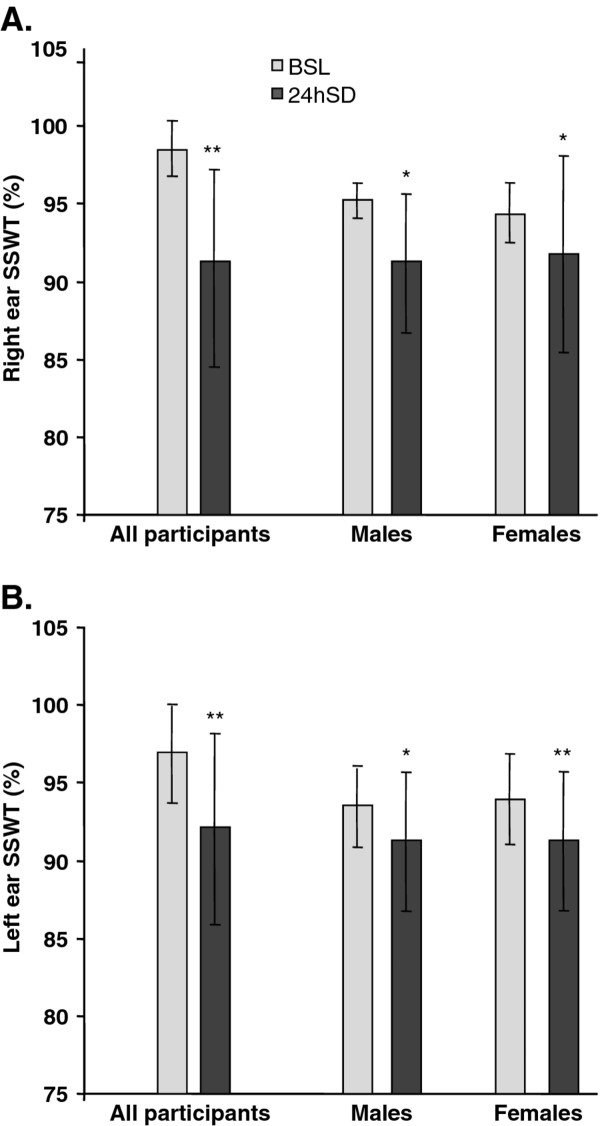
SSWT performance was impaired by sleep deprivation. Mean SSWT times following 24 hours of sleep deprivation (24hSD) were significantly reduced compared to those observed during the baseline condition (BSL) without sleep deprivation. Error bars show standard deviations. *p ≤ 0.01, **p ≤ 0.001 vs. BSL for whole study cohort (left) or within gender subgroups.